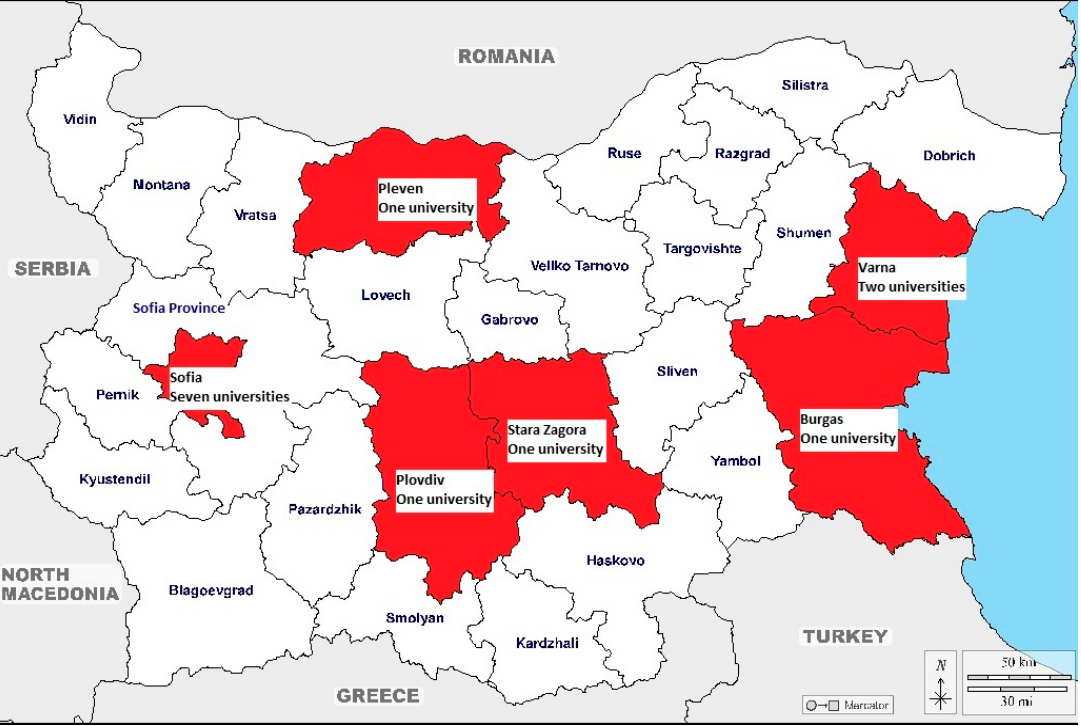
Figure 1. Geographic location of the Bulgarian universities from which there were respondents in the present study (in red).